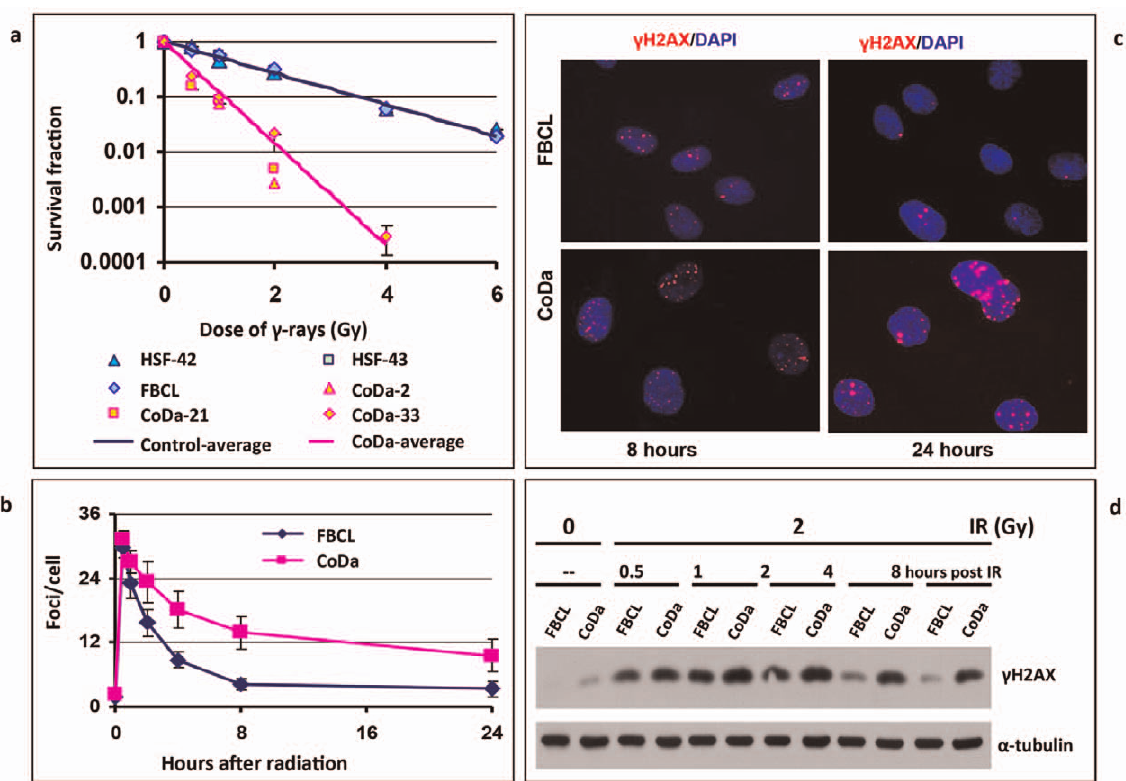
Figure 3. CoDa cells are hyper-sensitive to ionizing radiation and have defects in DNA double-strand break repair. (a) Cellular sensitivity of human fibroblasts to Cs-137 c -radiation measured by colony formation assay. Shown are the averages of 3–6 experiments with three CoDa clones (CoDa-2, 21, and 33), and 3–7 experiments with three independent control fibroblasts cell lines (FBCL, HSF-42, and HSF-43). Error bars are standard errors. (b) The numbers of c H2AX foci per cell in a normal fibroblast control line (FBCL) and CoDa cells. At different time points after the cells were treated with c -radiation, cells were fixed and stained by immunoflurescent techniques with an anti- c H2AX antibody. The number of c H2AX foci was counted in . 400 cells per time point in each experiment. Shown are averages and standard deviations of three experiments. (c) The representative images of c H2AX nuclear foci at 4 and 24 hours after IR treatment. DAPI staining shows the location of nuclear. (d) The total c H2AX protein level measured by anti- c H2AX western blot after irradiation (2 Gy) in FBCL and CoDa cells. b -actin was used as a loading